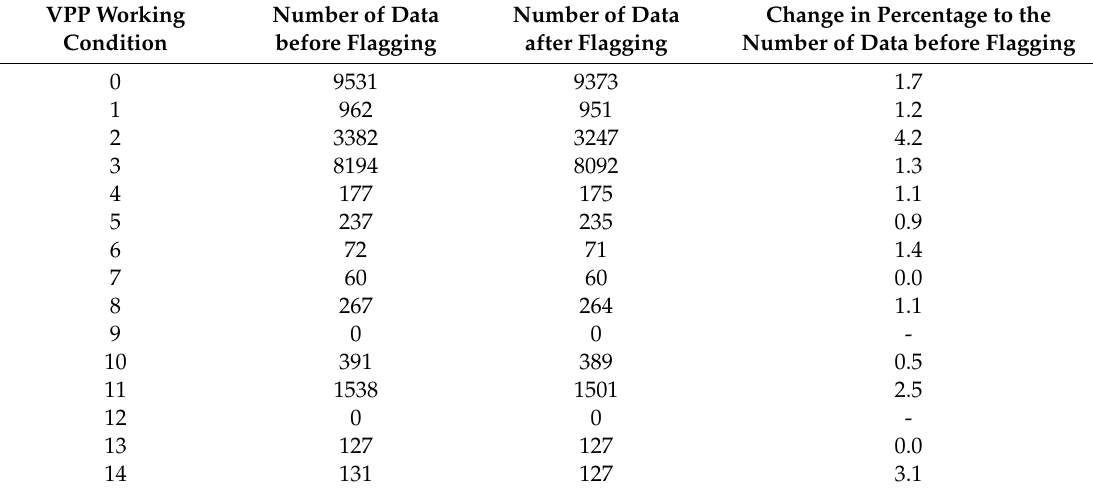
Table 7. Impact of flagging concept for area-related